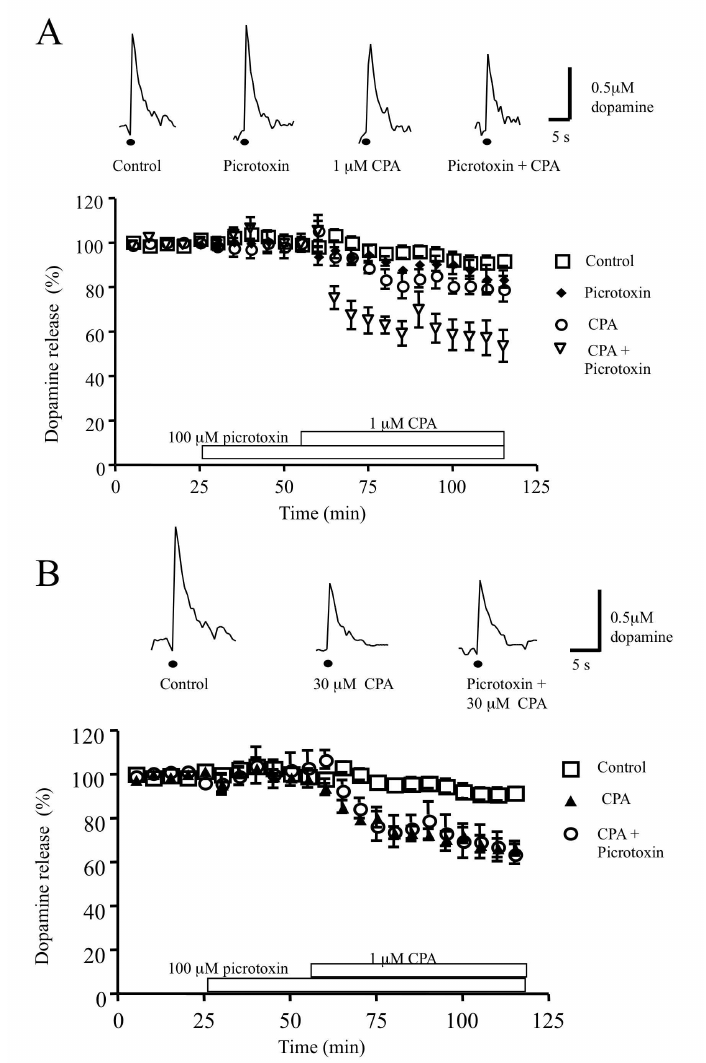
Figure 6. Picrotoxin enhances the inhibitory effect of 1 m M CPA but not 30 m M CPA on dopamine